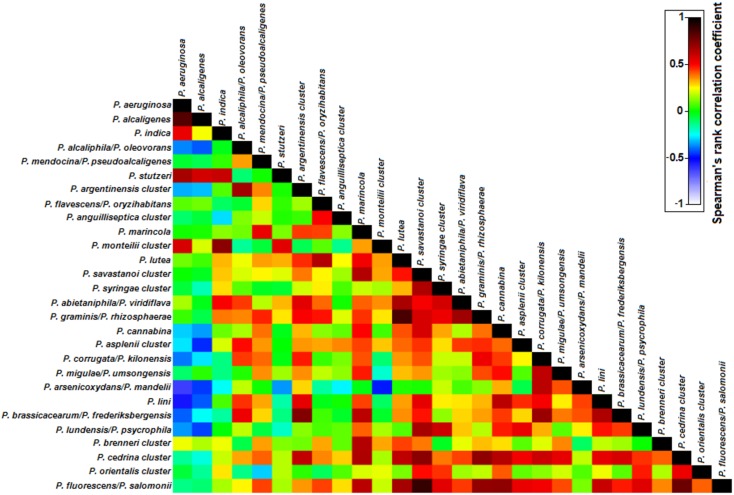
Spearman’s rank correlation matrix of the Pseudomonas phylotypes in the analyzed cooling tower water samples. Phylotypes listed were detected in at least 50% of the water samples. The colors of the bar indicate the nature and degree of correlation with 1 indicating maximum positive association and -1 indicating maximum negative correlation between two phylotypes.